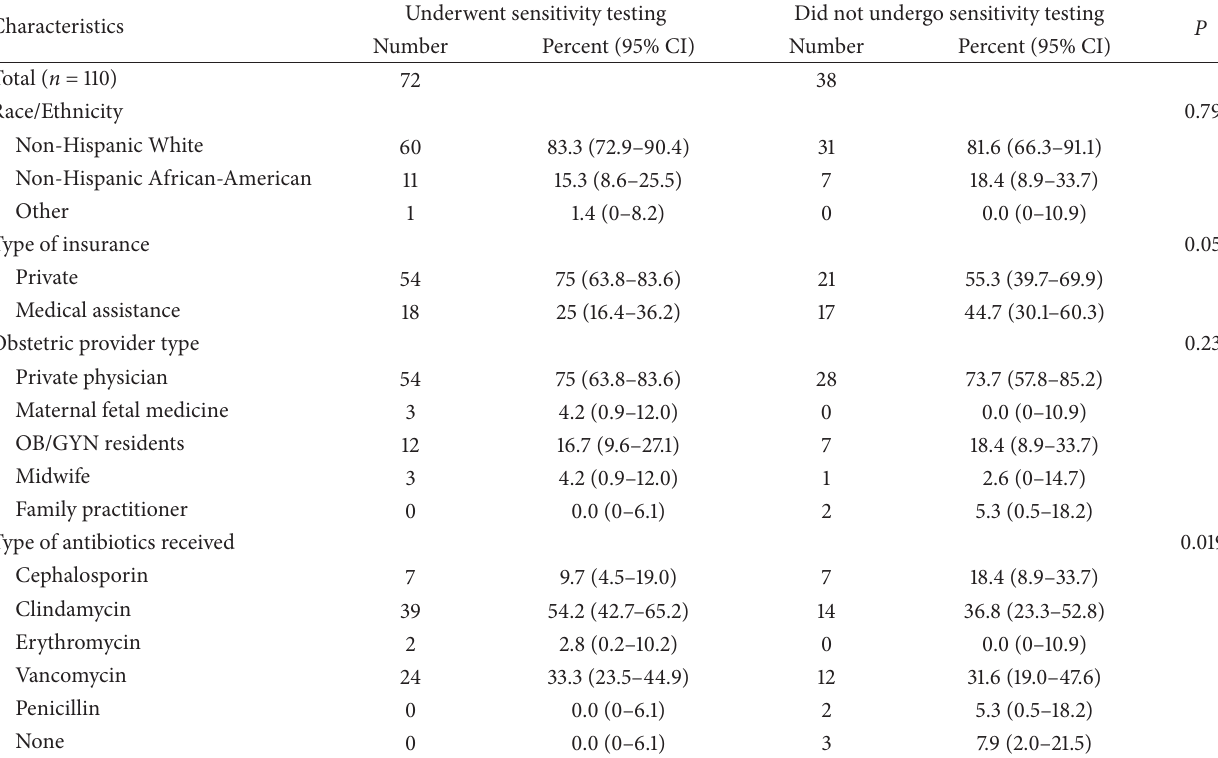
Table 2: GBS+, penicillin-allergic patients who delivered at Magee-Womens Hospital in 2010. Comparisons between women who had antibiotic sensitivity testing and women who did